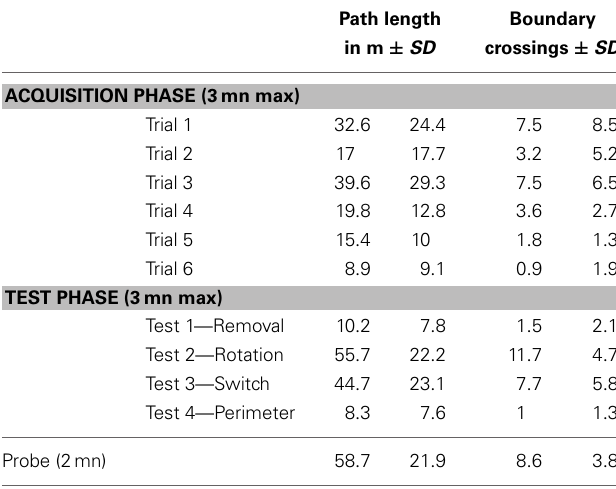
Table 1 | Parameters of level of performance during the different phases of the experiment.